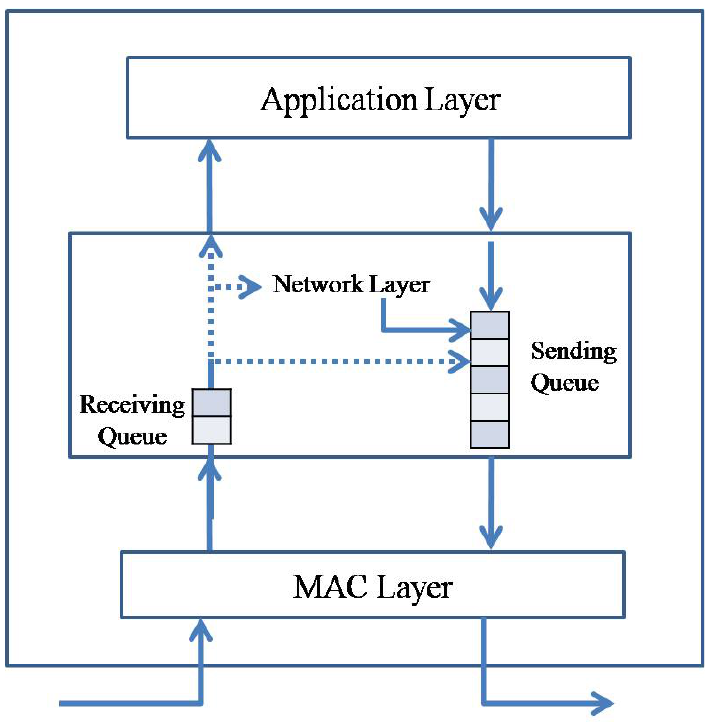
Figure 1. Packet flow in a sensor node. A sensor node has two queues, receiving queue for received packets and sending queue for generated packets and transit